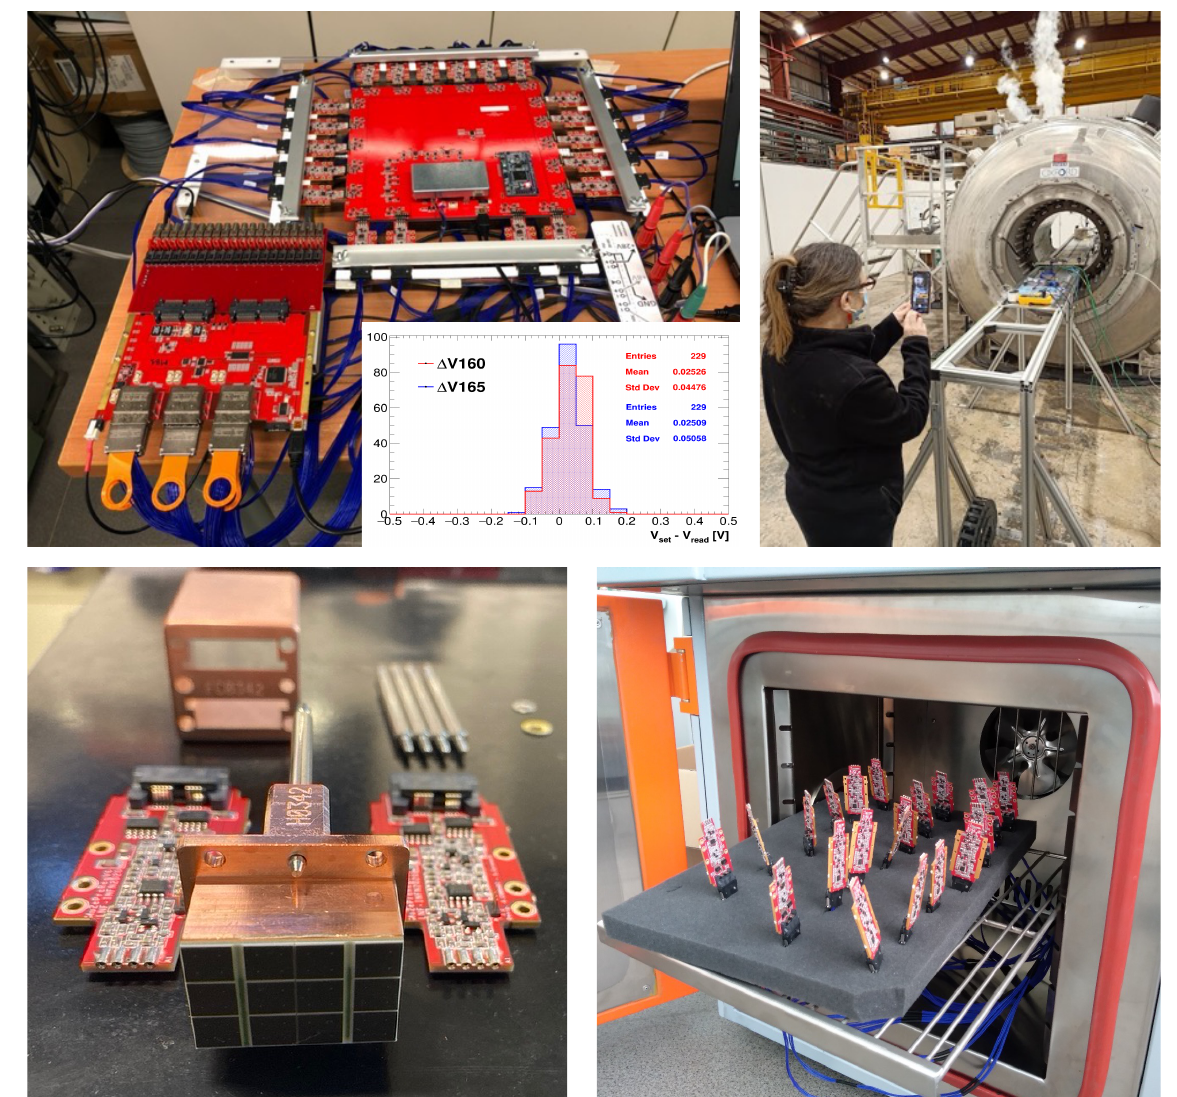
Figure 6. FEE QA bench ( top-left ), calibration results for HV regulator output are also shown. Test in magnetic fields at Argonne National Laboratory ( top-right ). ROU before assembly with the FEE boards ( bottom-left ). FEE burn-in test ( bottom-right